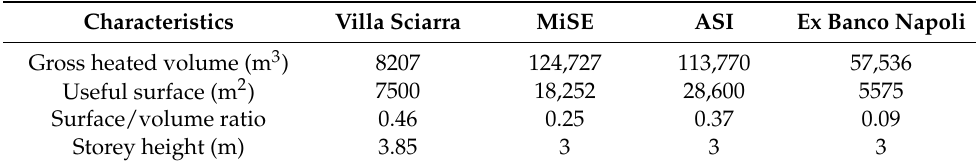
Table 1. Actual situation characteristics of the analyzed